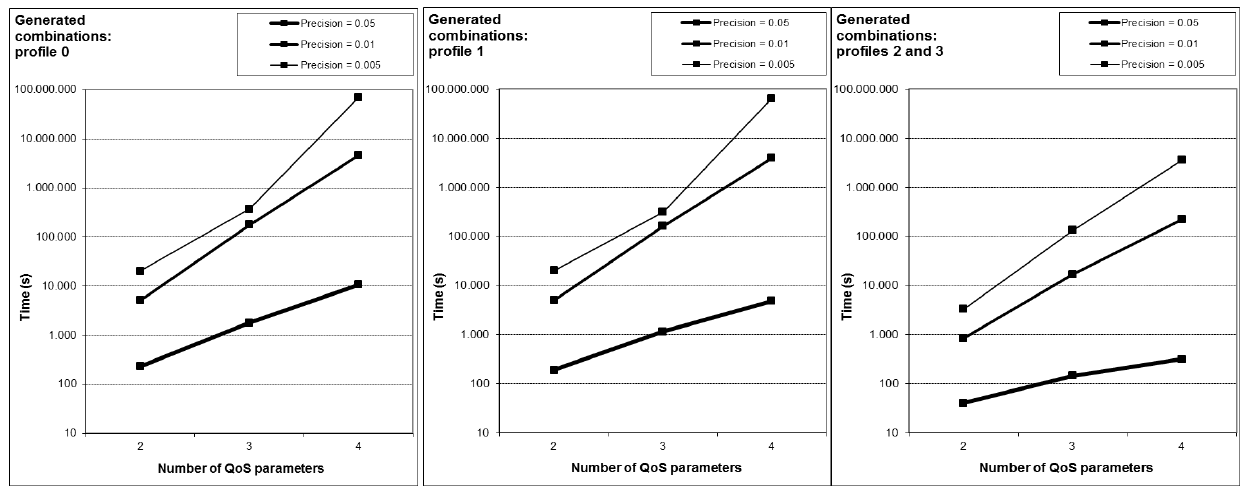
Figure 6. Experimental results: Generated combinations for each profile and